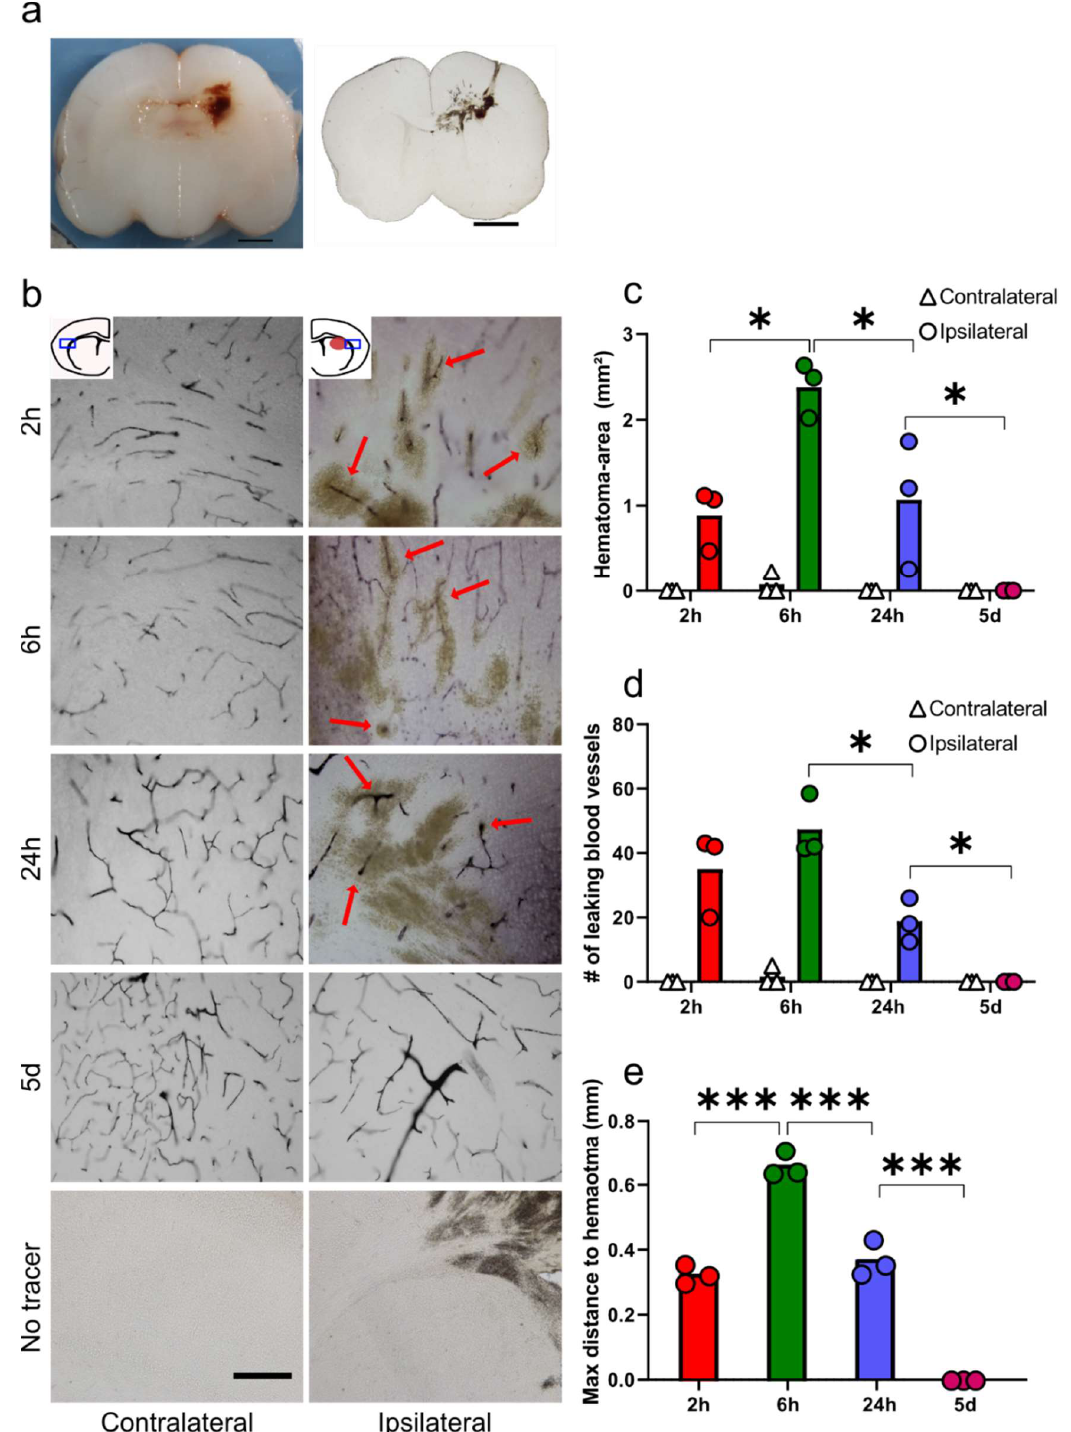
Figure 1. Functional blood-brain barrier assessment and quantification of leaking blood vessels using molecular tracers. ( a ) The hematoma is macroscopically visible in brains during processing and after sectioning. ( b ) Representative images of tracer distribution (red arrows) found in the area around the hematoma at different times following germinal matrix haemorrhage (GMH). Note that around the core hematoma, blood-brain barrier (BBB) function was compromised in some vessels up until 24 h following GMH. ( c ) The size of the hematoma after GMH. ( d ) Number of leaking blood vessels at different times after GMH in the peri-hematoma region. ( e ) Maximum distance to leaky blood vessels from the edge of the hematoma animals after GMH. One-way ANOVA with the Holm–Šídák multiple comparisons test, * p ≤ 0.05, *** p ≤ 0.001. n = 3 for all time-points, bar graphs represent mean values. Scale bars are 2 mm ( a ) and 100 µm ( b ).